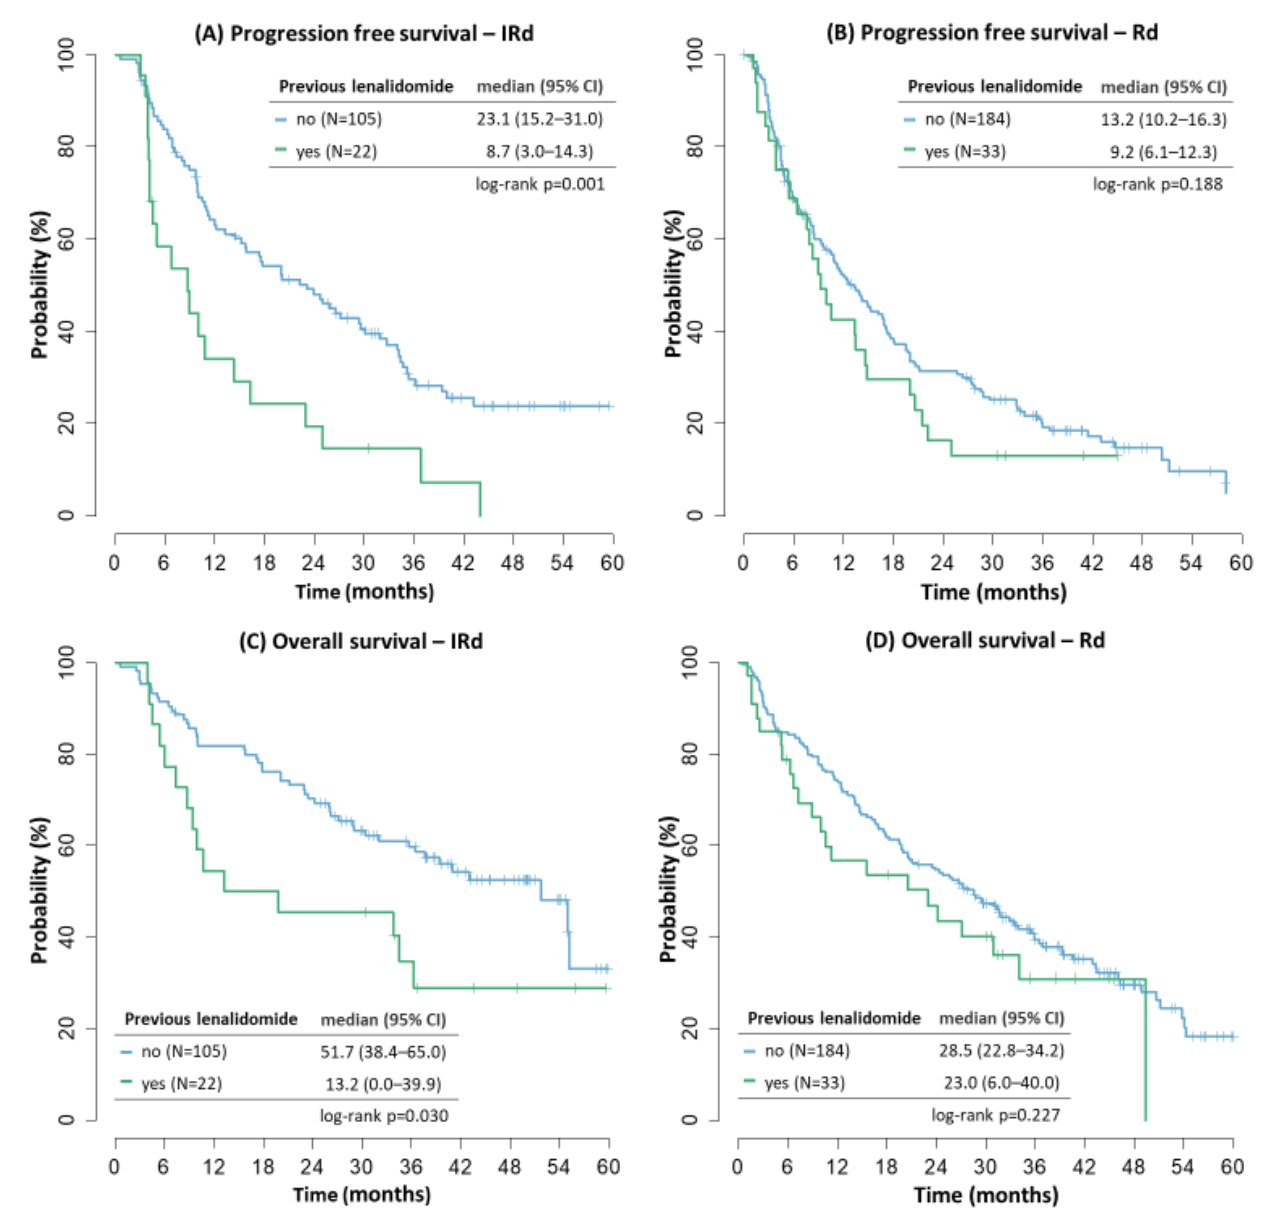
Figure 5. Progression free survival and overall survival by lenalidomide pretreatment. Monoclonal antibodies were used more frequently in patients with previous IRD vs. RD treatment (daratumumab—16.3% vs. 4.3%, p = 0.0054; isatuximab 5.0% vs. 0.0%, p = 0.026). Similarly, significantly more patients with previous IRD vs. RD received sub- sequent carfilzomib (12.5 vs. 1.7%, p = 0.004). Patients relapsing from RD were more frequently treated with ixazomib (6.8%), nivolumab (2.6%) or ibrutinib (1.7%) but the differences were not